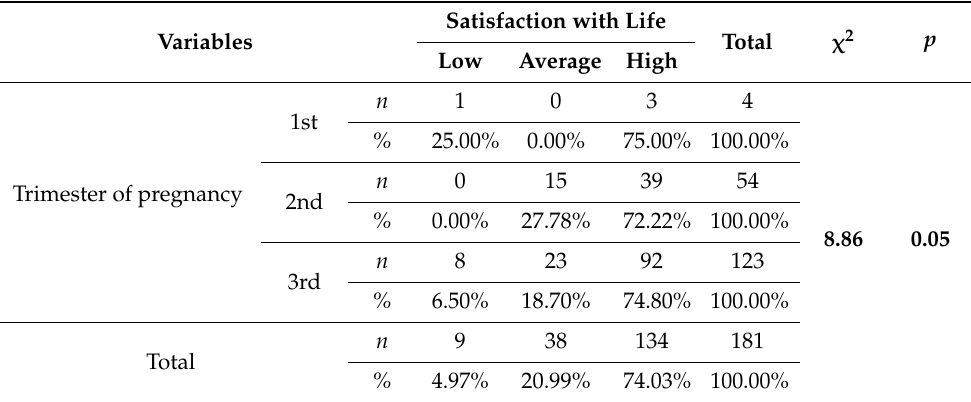
Trimester of pregnancy